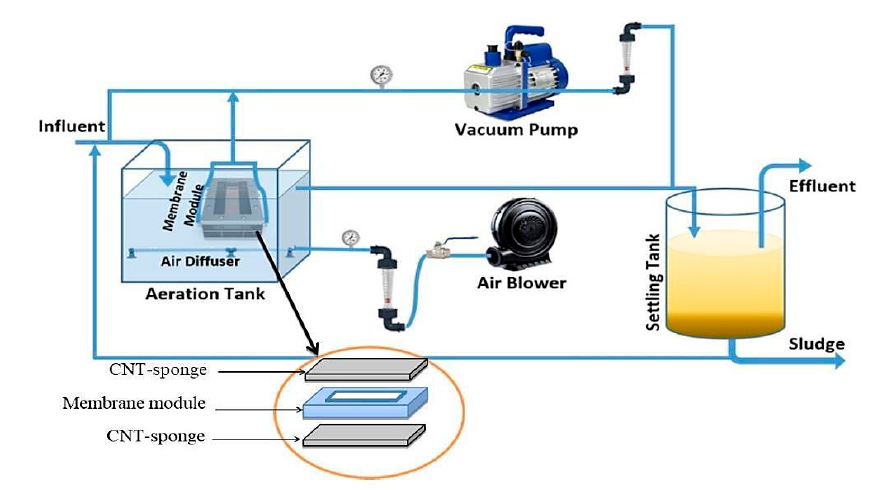
Figure 2. Schematic diagram of the lab-scale AS-MBR system.